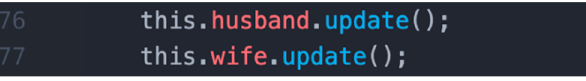
Figure 4. Husband and wife in code.